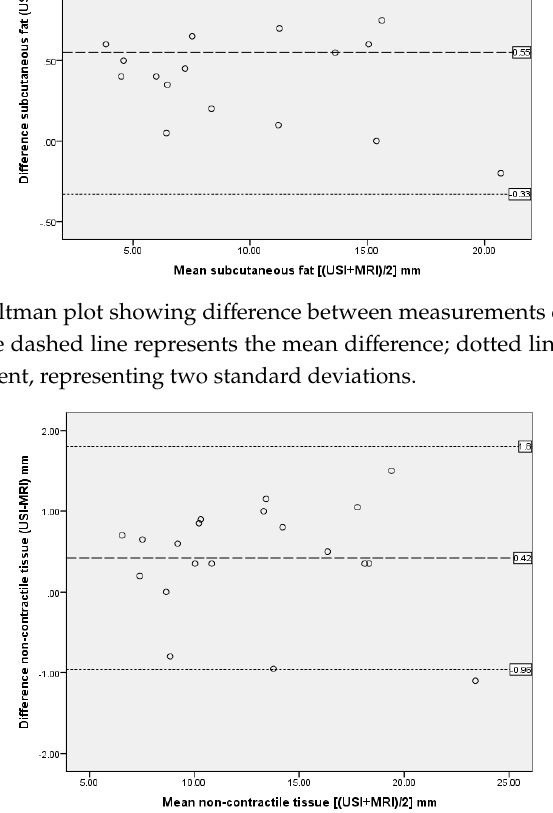
Figure 7. Bland and Altman plot showing difference between measurements of non-contractile tissue from MRI and US scan. The dashed line represents the mean difference; dotted lines are 95% upper and lower limits of agreement, representing two standard deviations.